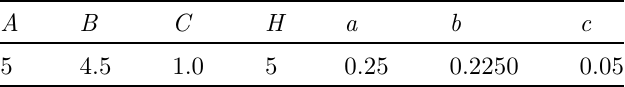
Table 1. Material constants for the sandy soil model used in the simulations [8]. Table 2. Geometrical parameters of the unit cells presented in Figure 1A,B and Figure 2A. All the given parameters are in